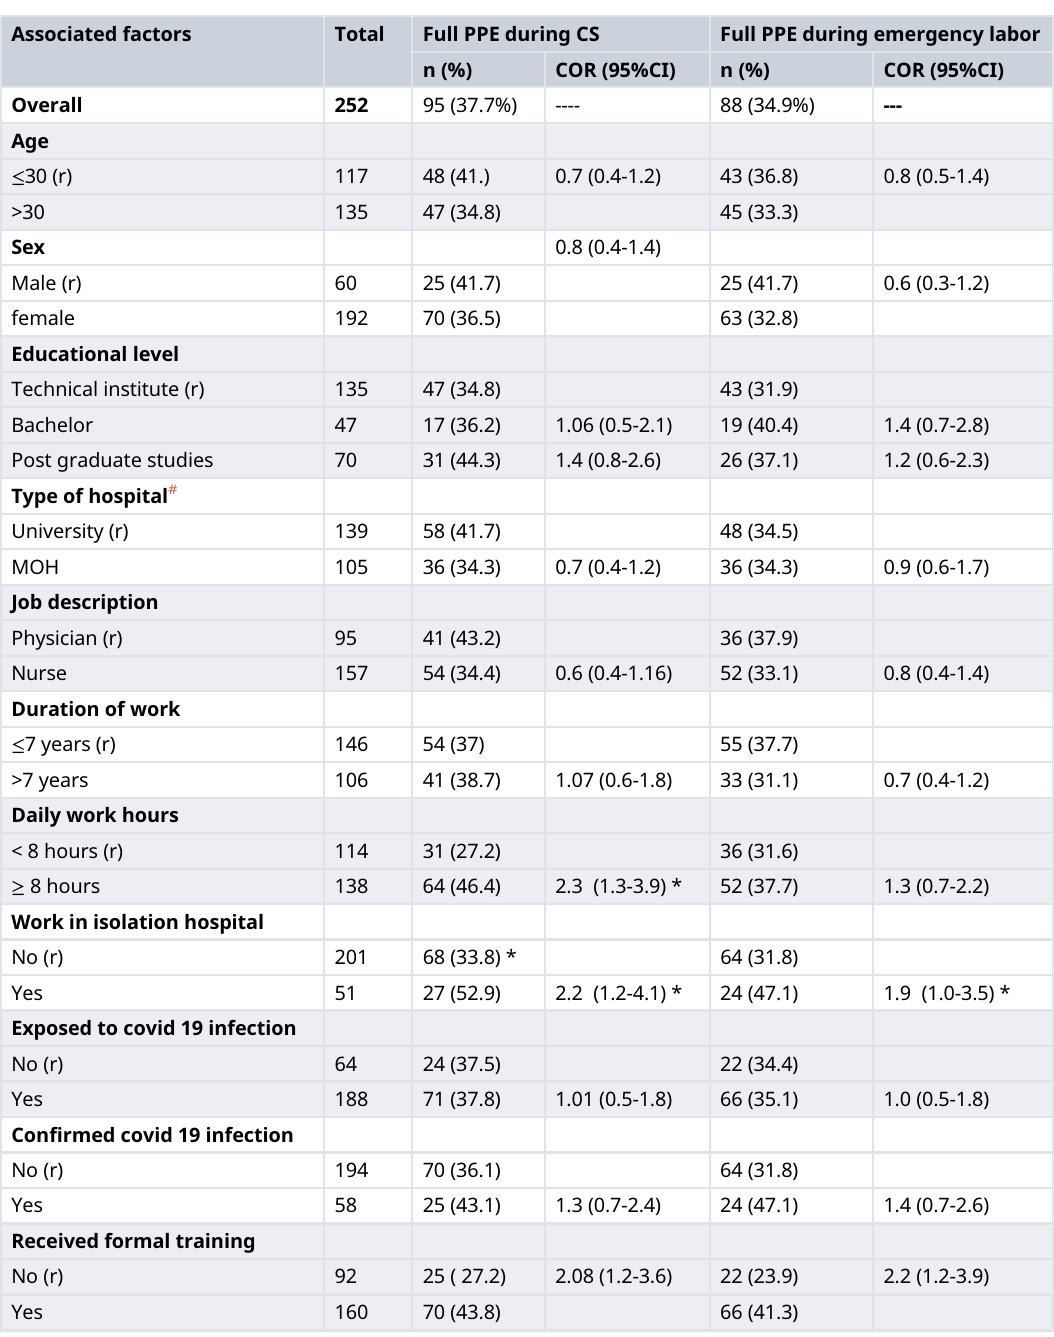
Table 1. Factors associated with full PPE use among study participants during CS & emergency